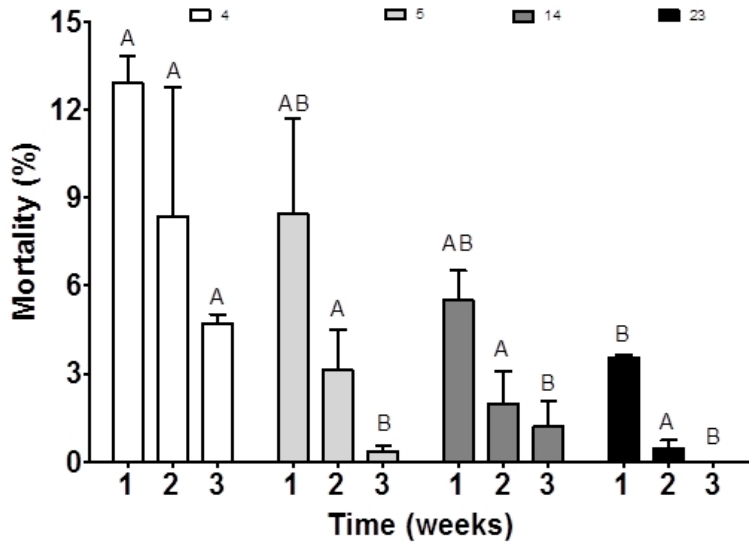
Figure 3. Effect of ARA on the hatching rate derived from medaka broodstock fed diets with different amounts of ARA (4, 5, 14, 23 mg g − 1 TFA) for three weeks. The values are means ± standard deviation (SD); each dietary treatment was carried out in triplicate (n = 3).